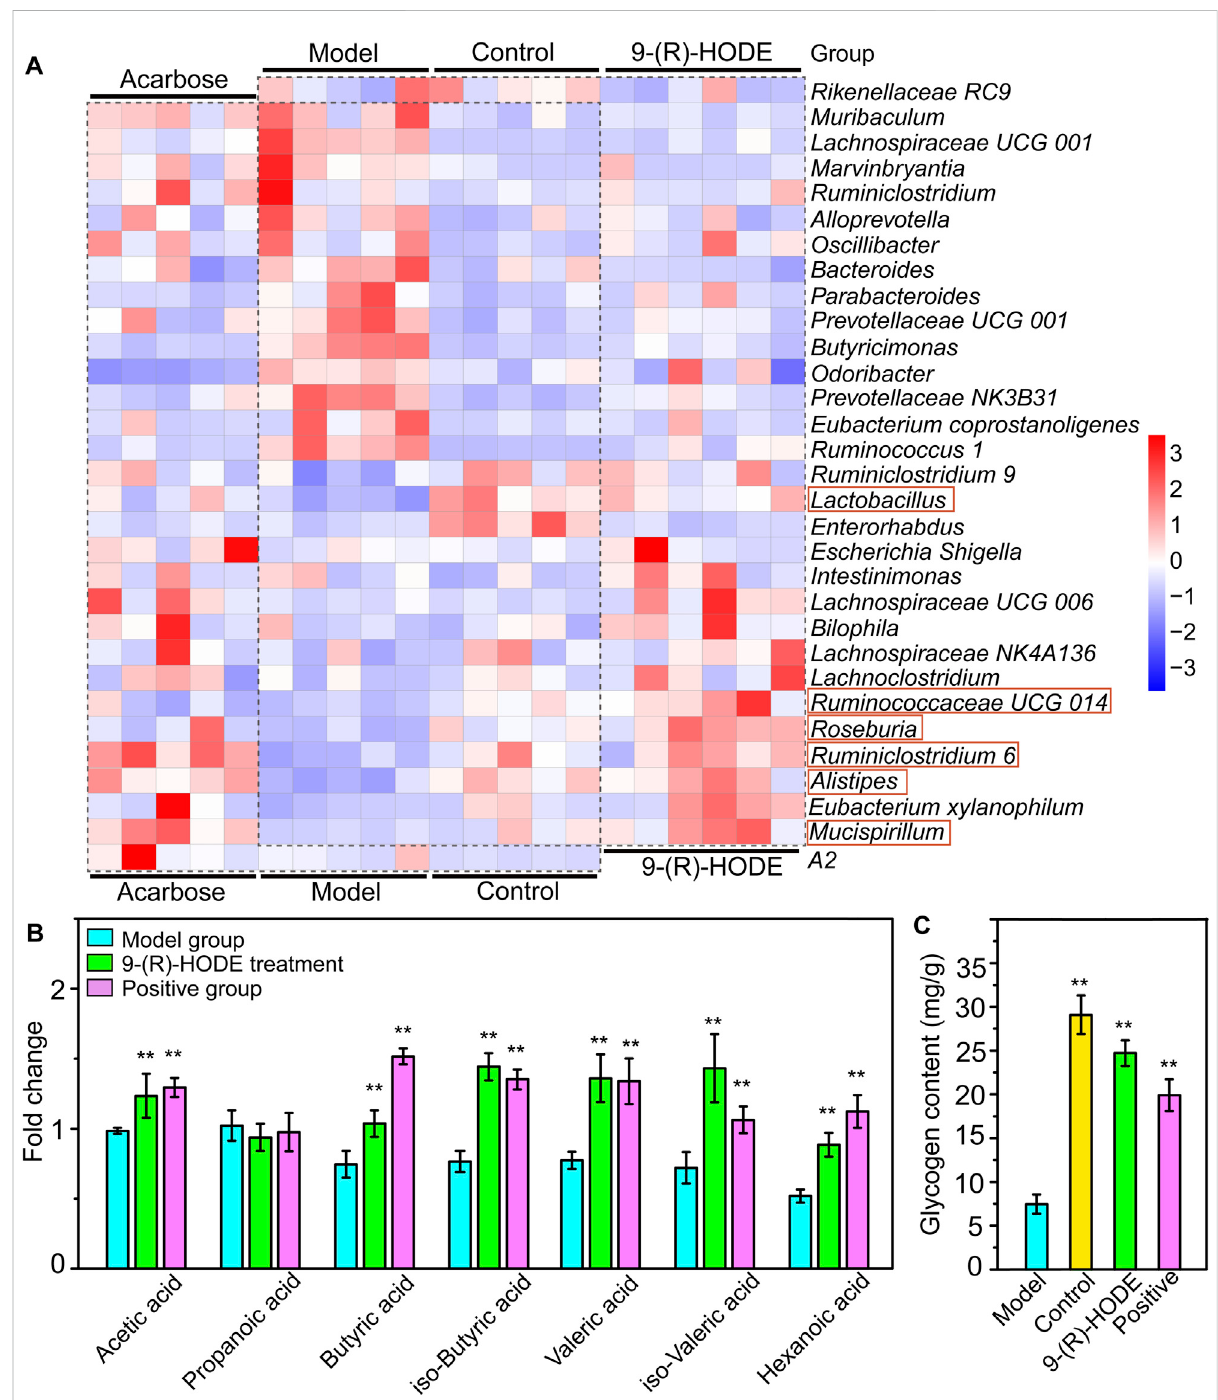
FIGURE 8 Effectof9-(R)-HODEandacarboseongutmicrobiota. (A) Lineardiscriminantanalysis(LDA)scoresfromLEfSe(LDAeffectsize)atthefamilyand genus levels. f: At the family level; g: at the genus level. (B) Heatmap of the top 30 most abundant differential microbiota at the family level (red rectangles represent SCFA-producing